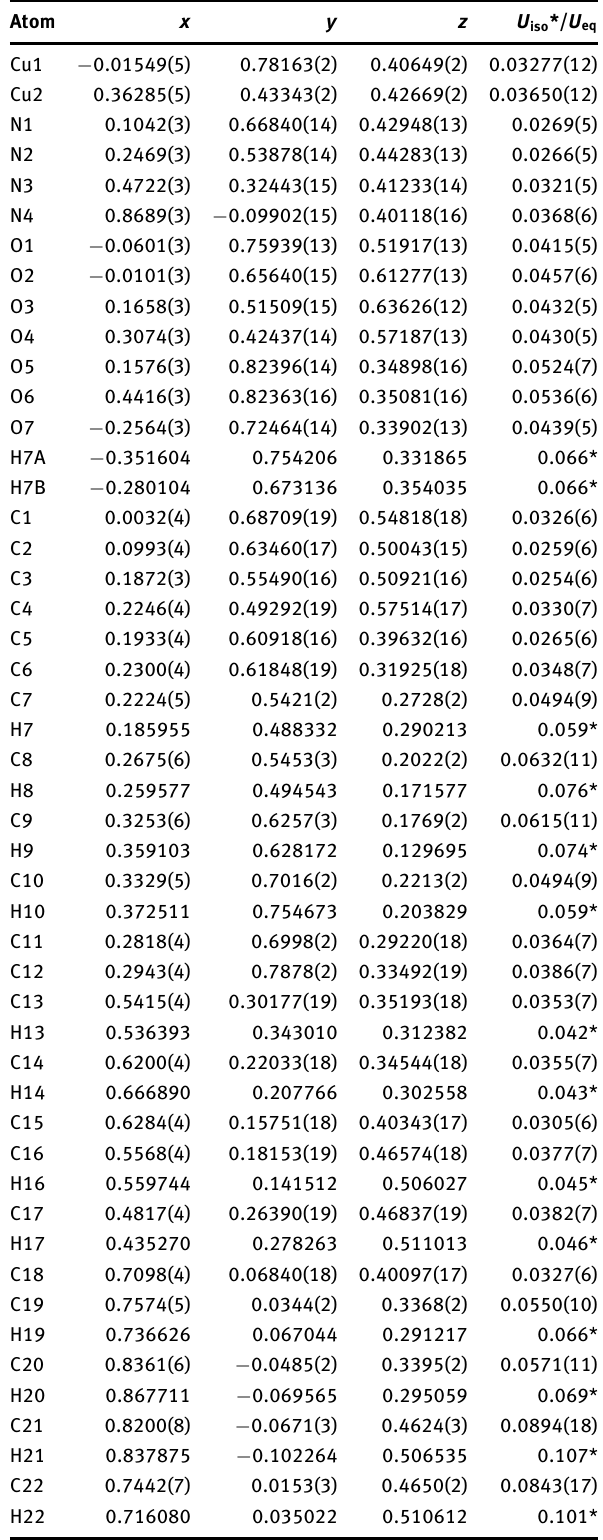
Table 2: Fractional atomic coordinates and isotropic or equivalent isotropic displacement parameters (Å 2